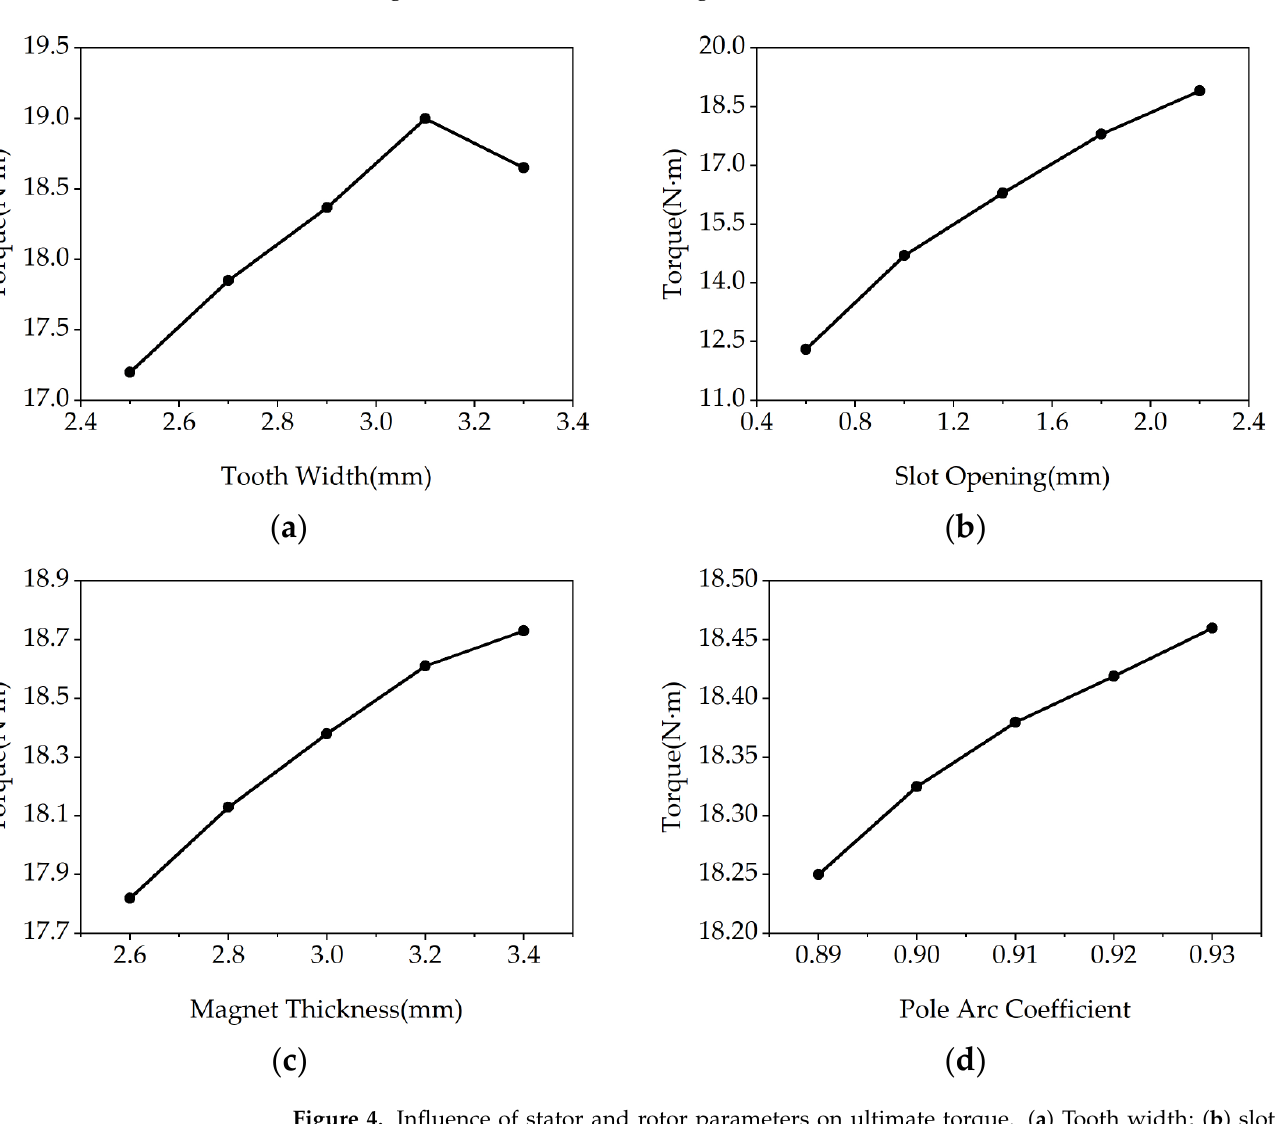
Figure 4. Influence of stator and rotor parameters on ultimate torque. ( a ) Tooth width; ( b ) slot opening; ( c ) magnet thickness; ( d ) pole arc coefficient.